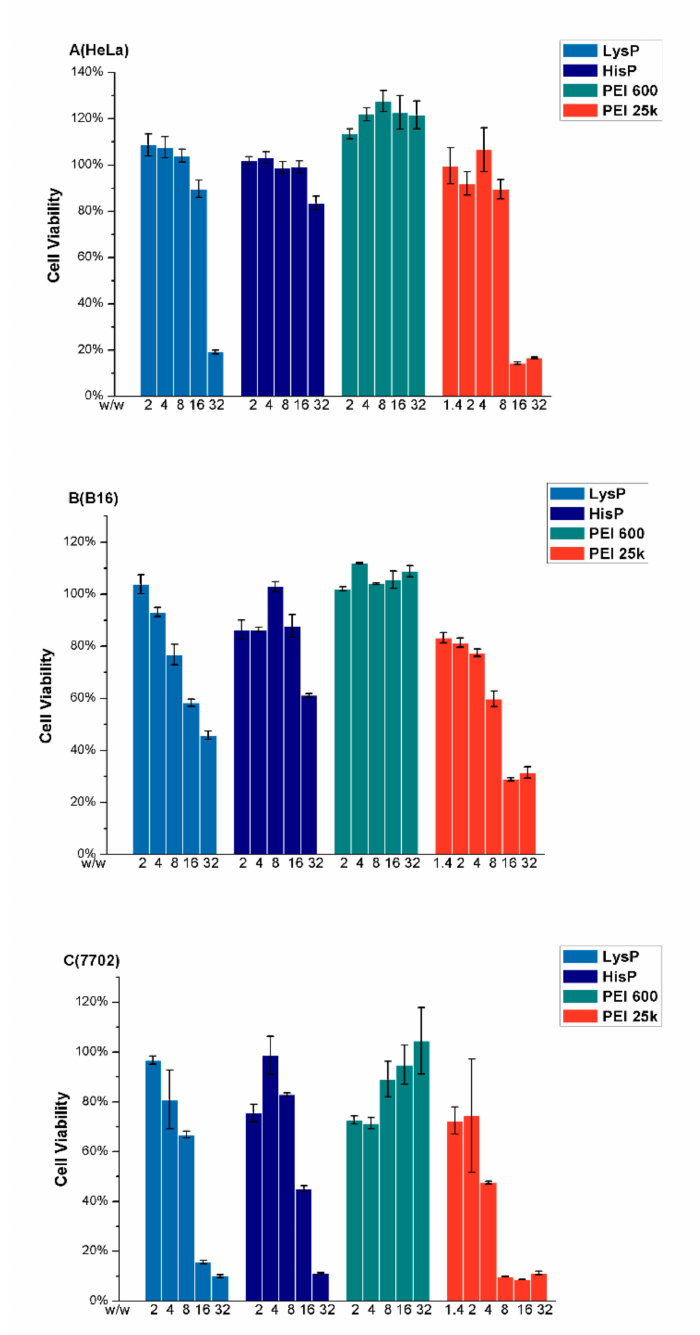
Figure 4. Cytotoxicity of the polyplexes at di ff erent weight ratios in HeLa ( A ), B16 ( B ), and 7702 ( C ) cells. PEI 600 Da and PEI 25 kDa ( w / w = 1.4) were used as